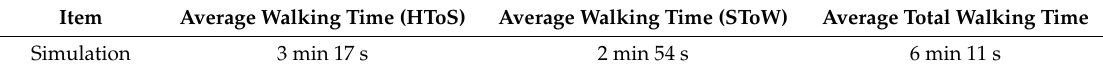
Table 6. The walking time results from our simulation. HToS, home to metro stop; SToW, metro stop to